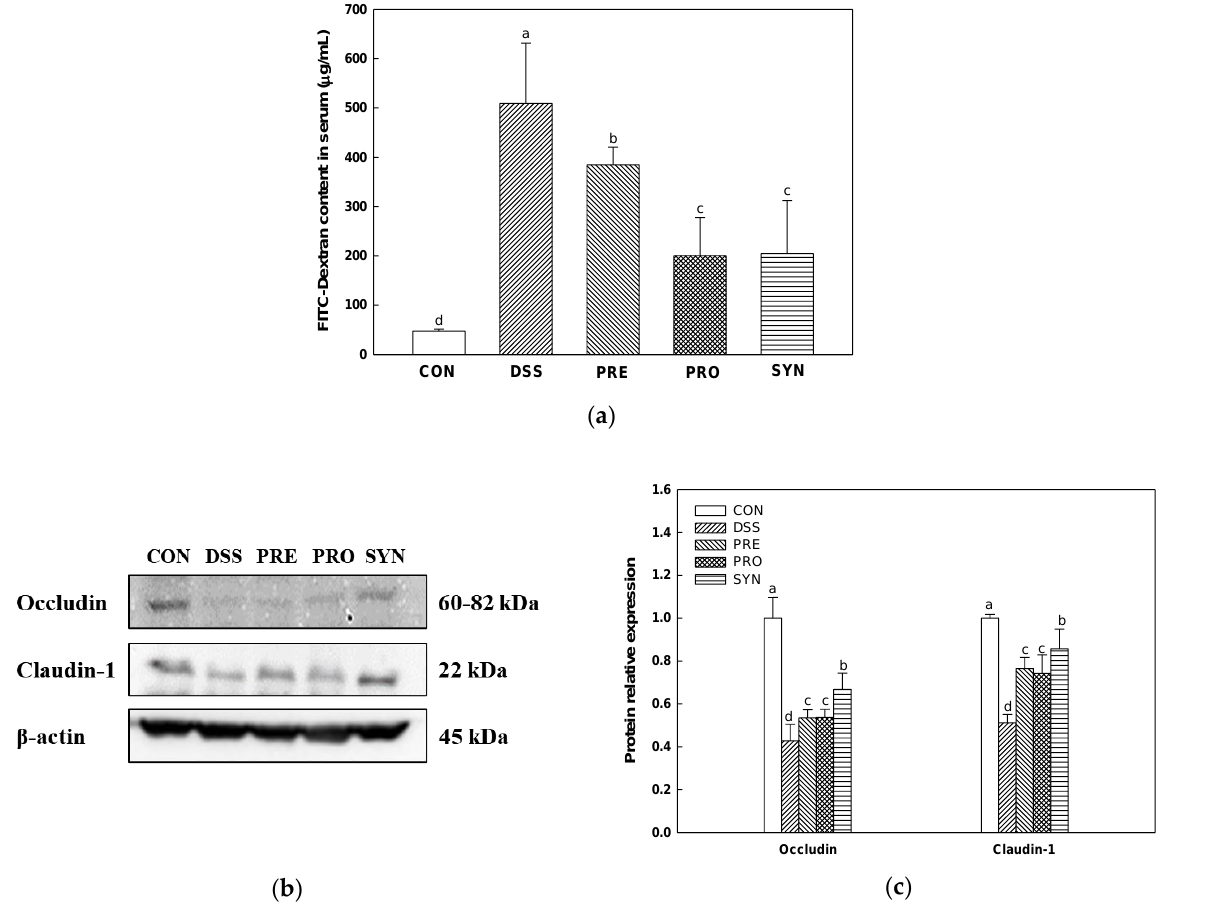
Figure 2. Effects of PRE, PRO, and SYN on permeability and junction proteins of DSS-induced colitis mice. Fluorescein isothiocyanate (FITC)-dextran levels in serum ( a ), Western blot band images ( b ), and the expression levels of tight junction proteins; occludin, and claudin-1 ( c ). The results were presented as the mean ± SD (FITC-dextran; n = 5, Western blot; n = 3). Data were statistically considered at p < 0.05, and different lowercase letters indicate significant differences between groups.